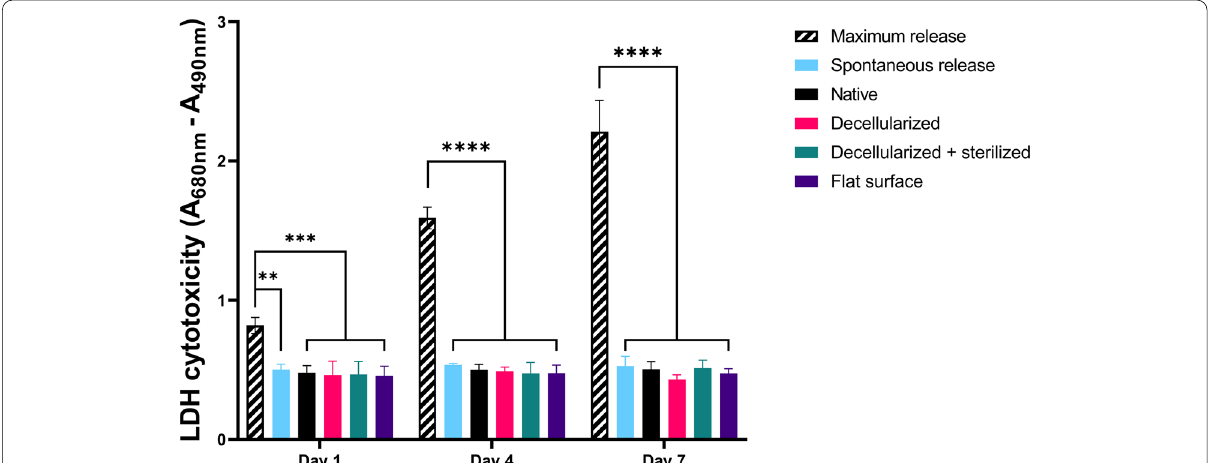
Fig. 5 Human decellularized and/or sterilized meniscus tissue is not cytotoxic. LDH cytotoxicity is measured as the LDH release by human dermal fibroblasts when seeded on native meniscus, decellularized meniscus, decellularized of < 0.01, *** indicates a p -value of < 0.001, **** indicates a p -value of <